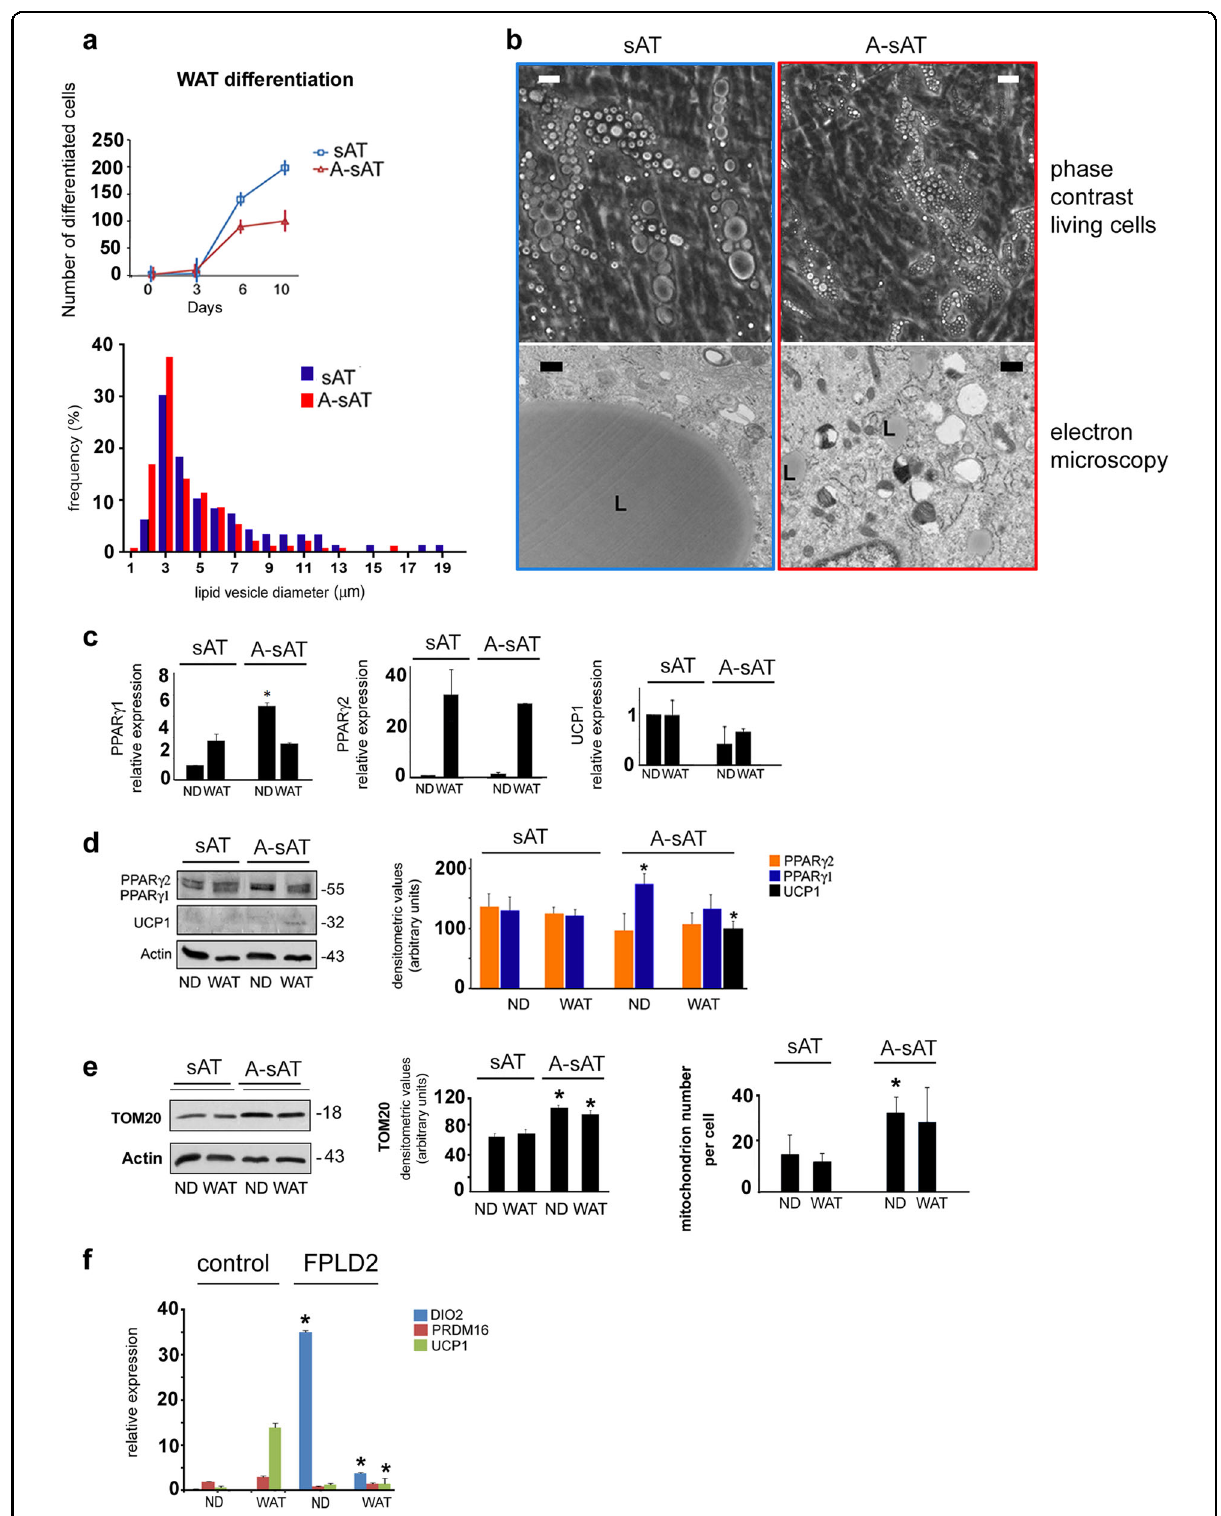
Fig. 4 (See legend on next